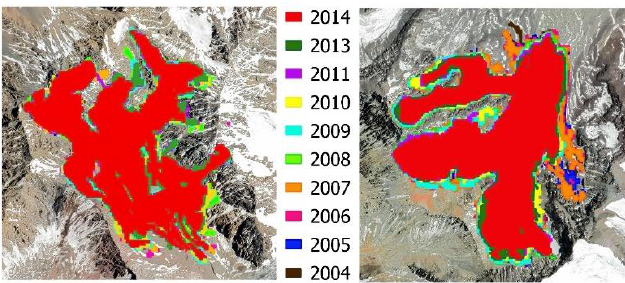
Figure 3. Mapped snow cover area for Bello glacier (left) and Olivares Alpha glacier (right)